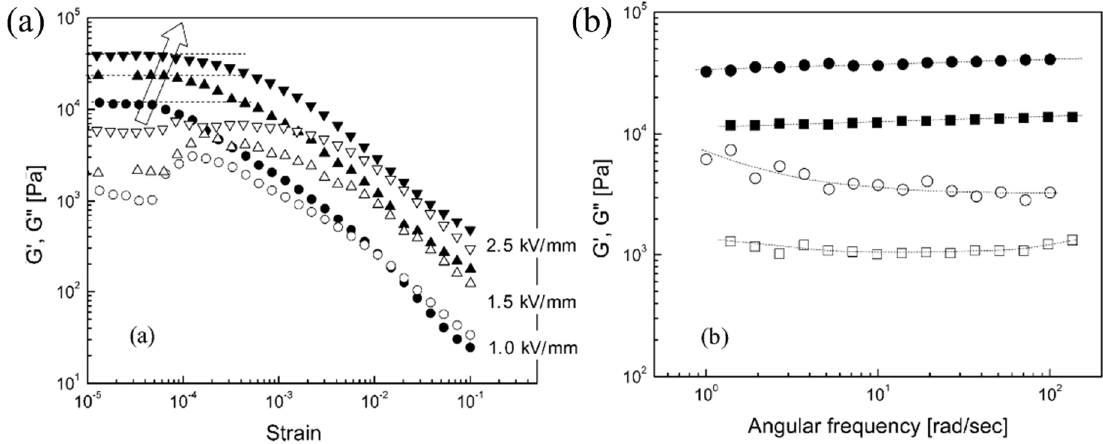
Figure 8. ( a ) Strain amplitude sweep of PANI/MCM-41 particles; ( b ) Angular frequency sweep of PANI/MCM-41 particle under 1 ( ■ ) and 2 ( ● ) kV/mm using a strain of 3 × 10 − 5 : Storage modulus (closed) and loss modulus (open) (Reproduced with permission from